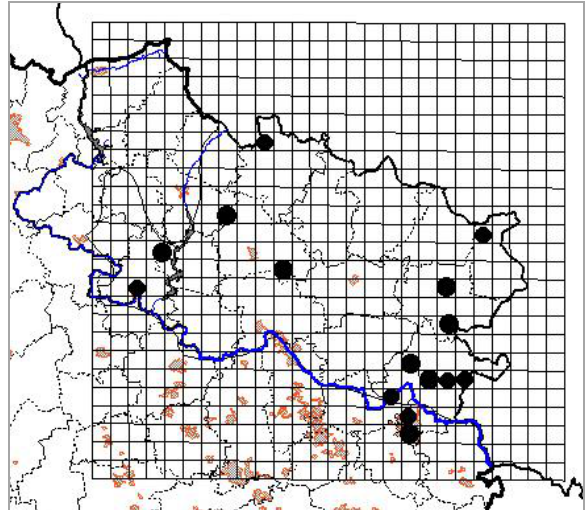
Fig. 2. The map of the distribution of Acer negundo L. in the Starobilsk grass-meadow steppe